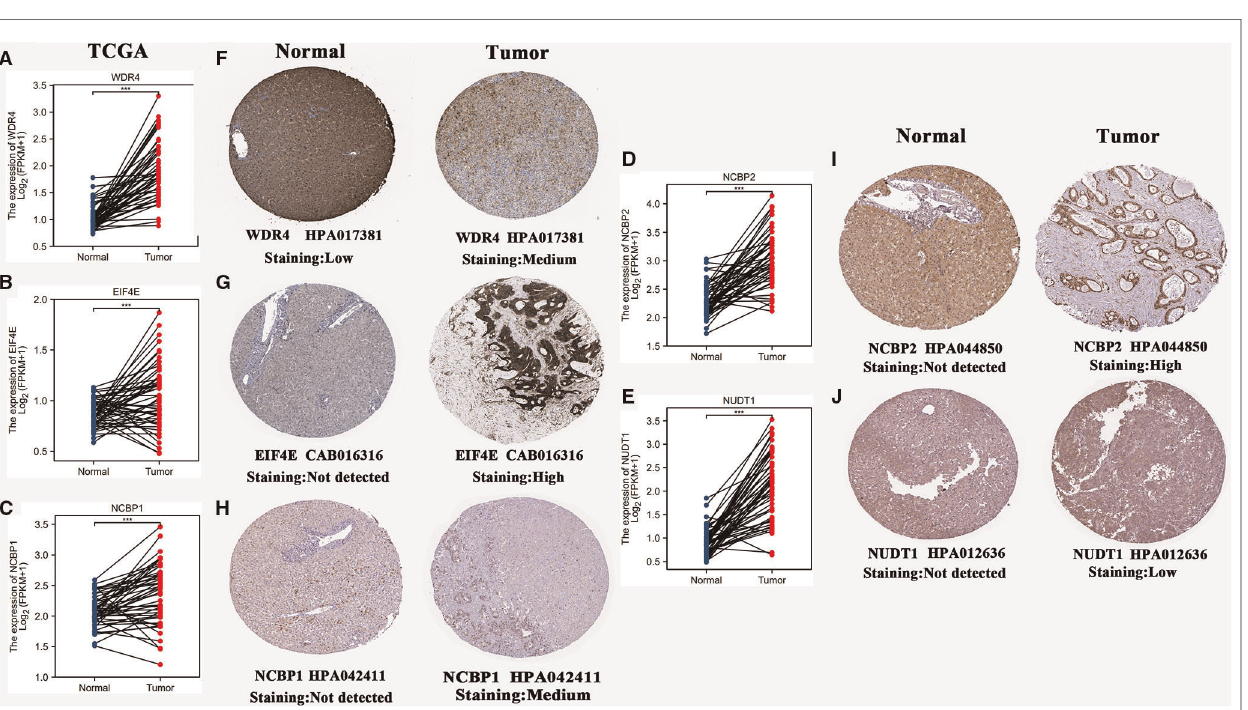
FIGURE 7 | Histological expressions of fi ve m7G signature genes. ( A – E ) Differences in mRNA expressions of 5 m7G genes between normal and HCC samples based on the TCGA-LIHC cohort. ( F – J ) Differences in histological expressions of 5 m7G genes between normal and HCC tissues based on the HPA database. The top of the fi gure indicates the category of the tissue specimen. The name of the m7G signature gene, the antibody type, and the staining intensity are listed at the bottom of each image. * P <0.05, ** P <0.01, *** P